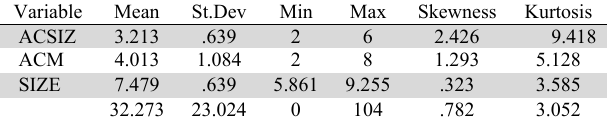
Descriptive Statistics of Dichotomous Variables